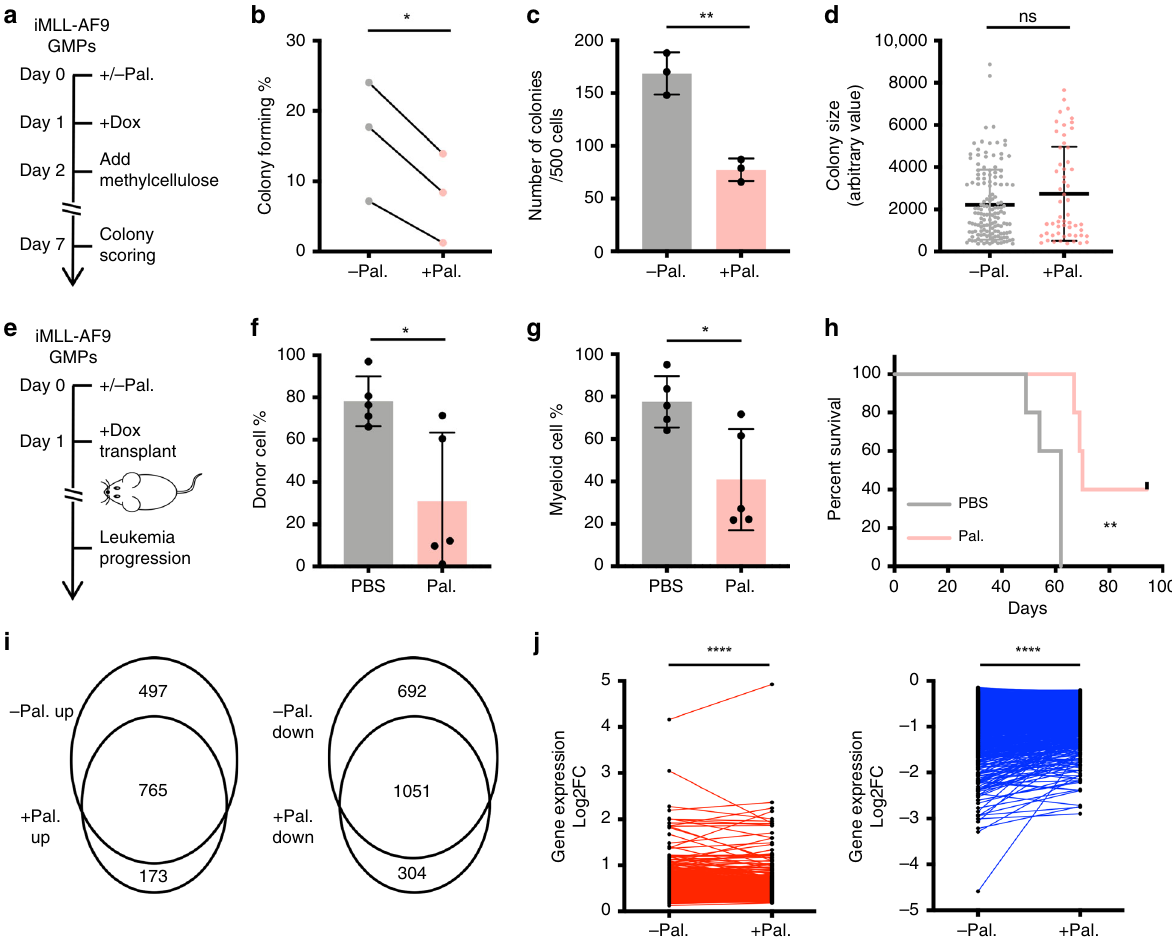
Fig. 6 Modi fi cation of the initial cell state by cell cycle inhibition mitigates MLL-AF9-mediated transformation. a Schematics illustrating the transformed colony formation by iMLL-AF9 GMPs + / − Pal. b Single-cell colony-forming assay showing colony forming ef fi ciencies from iMLL-AF9 GMPs transiently treated with palbociclib. Each pair of dots connected by the line represent colony forming ef fi ciencies of GMPs from a different iMLL-AF9 mouse; ( n = 3), p = 0.0221 by paired t -test. c , d Quanti fi cation of colony number c and size d of bulk cultured iMLL-AF9 GMPs in methylcellulose + / −